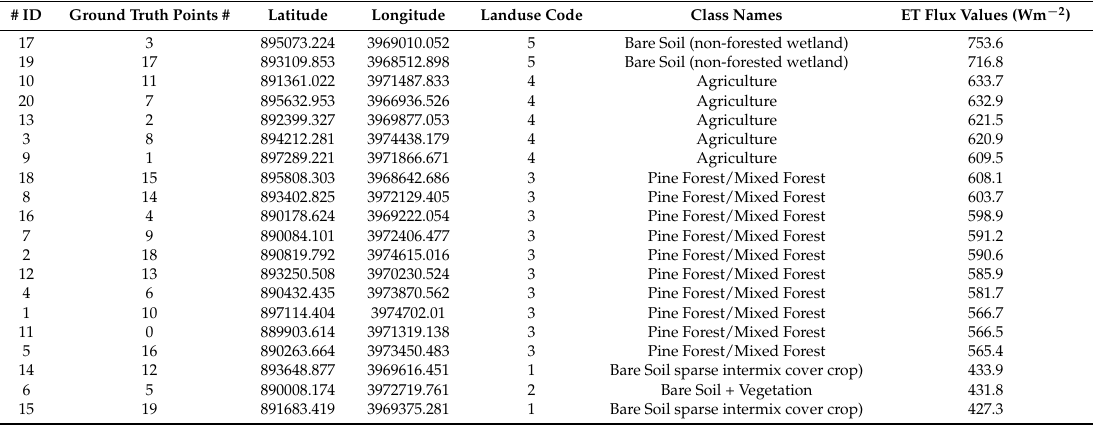
Table 5. Landuse versus ET flux values comparison with classified landuse map and the developed ET map of the study area for 5 September